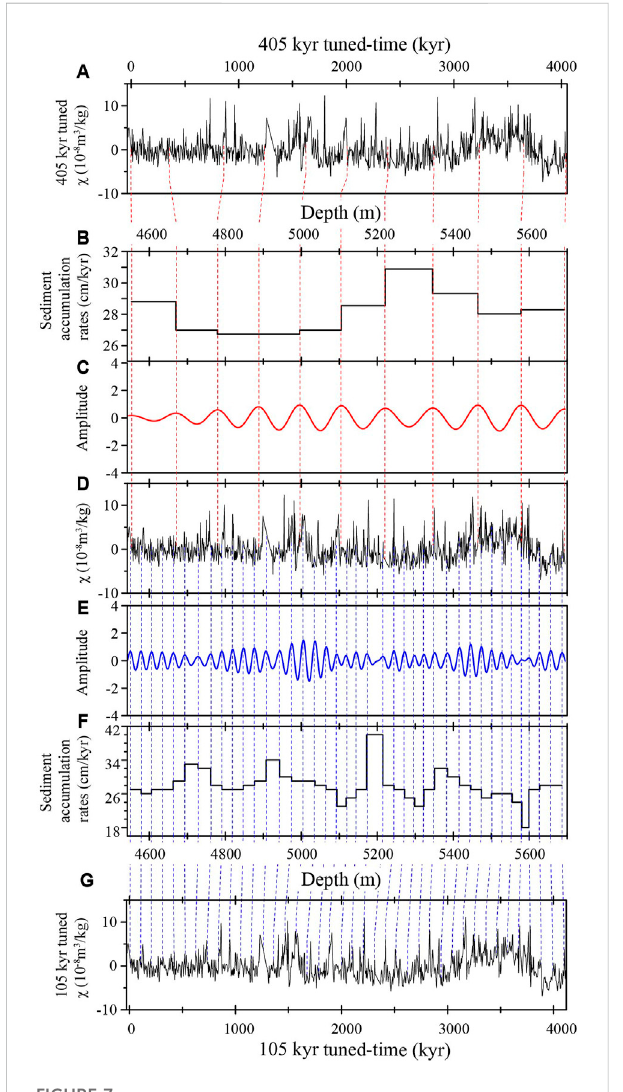
FIGURE 7 Depth-time transitions of the untuned χ series. The untuned χ series (D) were tuned by the 405-kyr signals extracted with bandpass fi lterof0.009± 0.002cycles/m (C) and105-kyrsignals extracted with bandpass fi lter of 0.035 ± 0.007 cycles/m (E) to get the 405-kyr tuned χ series (A) and 105-kyr tuned χ series (G, B, F) show the sedimentation accumulation rates estimated by the 405-kyr and 105- kyr tuning processes.